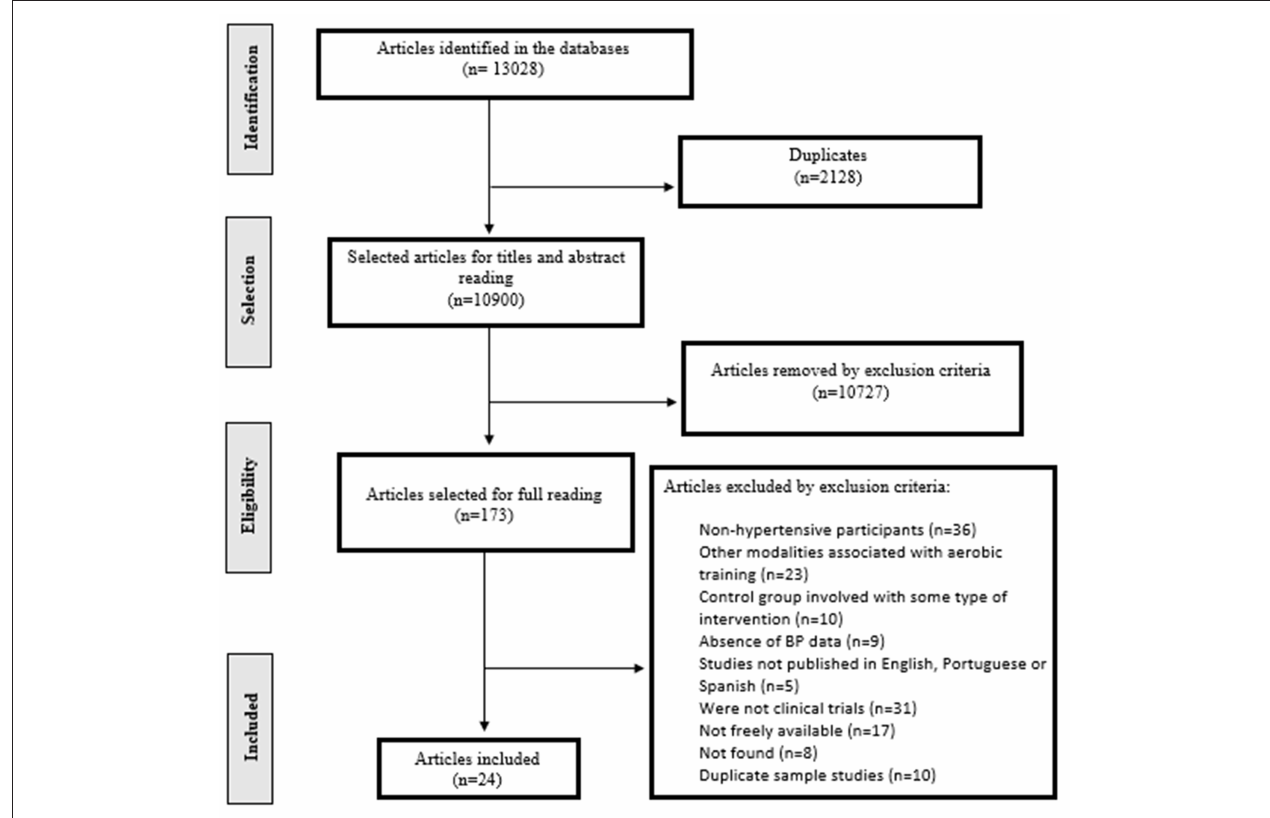
FIGURE 1 | Flowchart with information on the different phases of the systematic review.